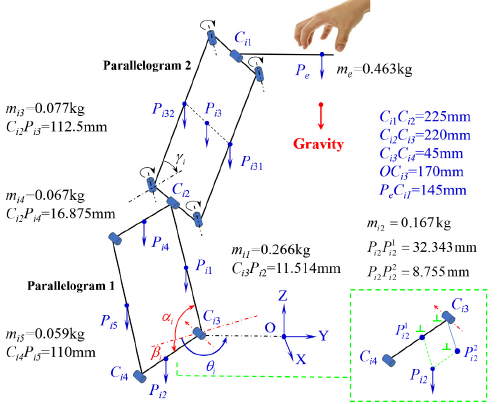
Figure 2. Diagram of the i th chain and mass properties of components.